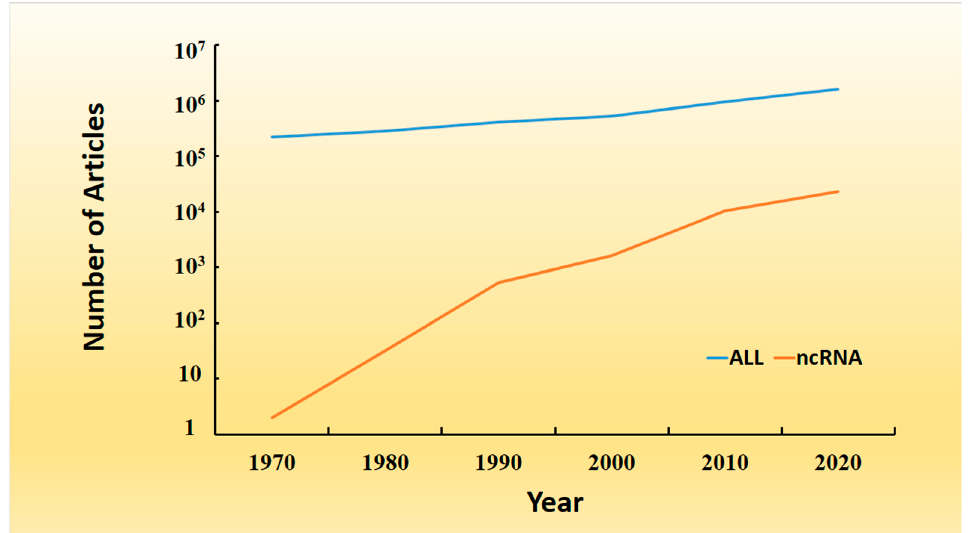
Figure 1. Growth of MEDLINE database. The number of articles published from the 1970s to the 2020s is shown chronologically. ‘All’ means all papers indexed in MEDLINE; ‘ncRNA’ means papers with keyword ‘ncRNA’.